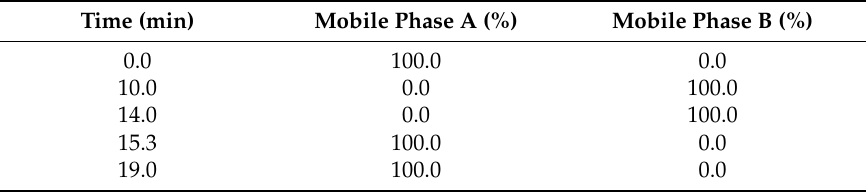
Table 2. Elution program for high-performance liquid chromatography